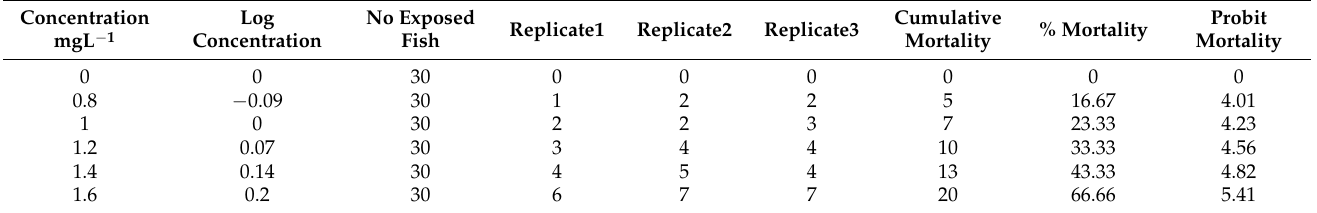
Table 2. Cumulative and probit mortality of experimental fish exposed to acute doses of the detergent